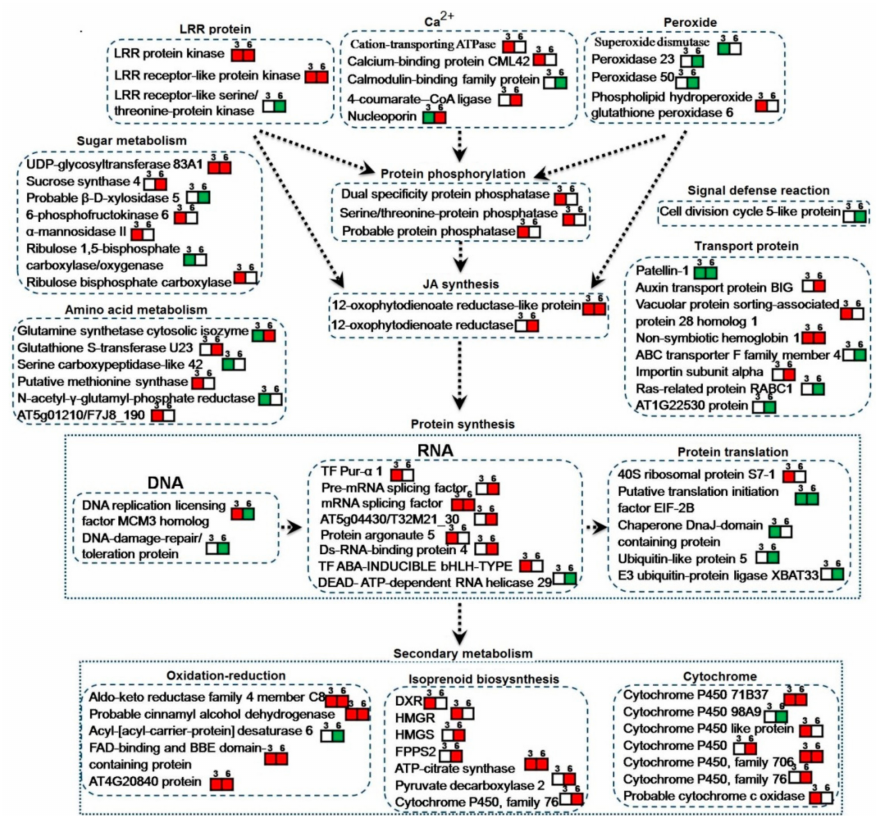
Figure 6. The action network map of 89 di ff erential proteins according to the Arabidopsis thaliana database. The number in the box indicates the number of PSF-treated days, red indicated significant increase and green indicated significant